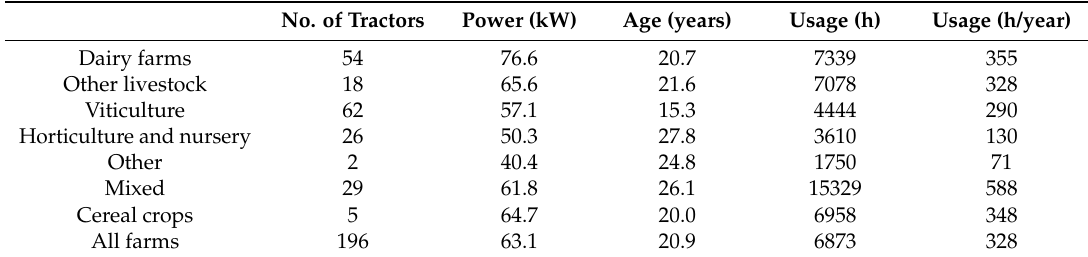
Table 5. Tractors at the